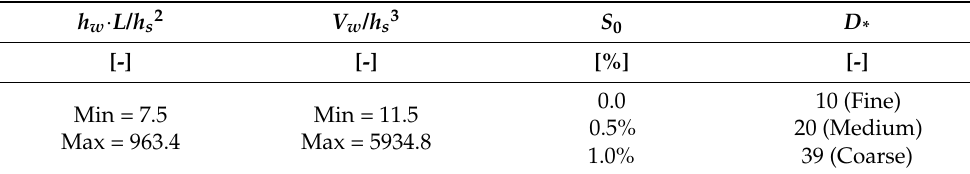
Table 1. Adopted values for the governing variables and